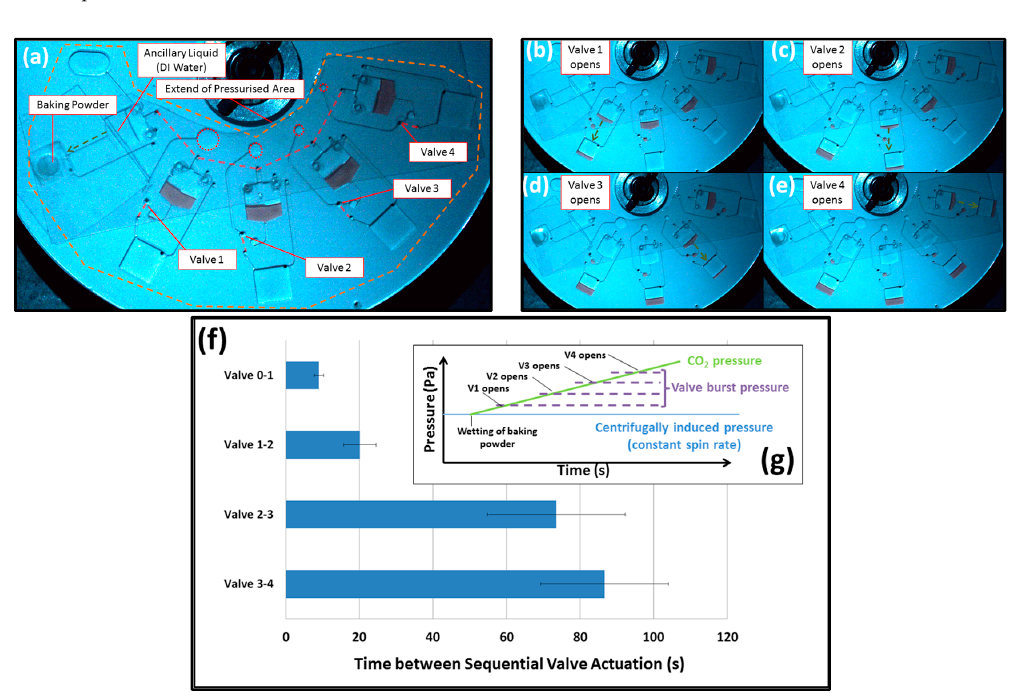
Figure 2. Volume governed valve actuation. ( a ) The baking powder is activated by the ancillary liquid (deionised (DI) water) to pressurize the interconnected cavities on the disc. Pneumatic chambers of each valve are highlighted and red dashed lines indicate connecting lower level channels ( b – e ). With increasing gas pressure, liquid is pumped into the dead-end pneumatic chambers (valves), successively disintegrating the DF. The order of valve actuation is governed by the compression ratio and thus the size of the pneumatic chambers; Valve 1, the largest chamber, is actuated first; ( f ) timing data of valve actuation ( n = 6); and ( g ) qualitative representation of the expected gas pressure changes in the disc; the rise in the CO 2 pressure has the same effect as an increase in spin rate. Note the disc was initially designed so that, in the absence of CO 2 , all DF burst valves will not trigger at or below 30 Hz spin rate.